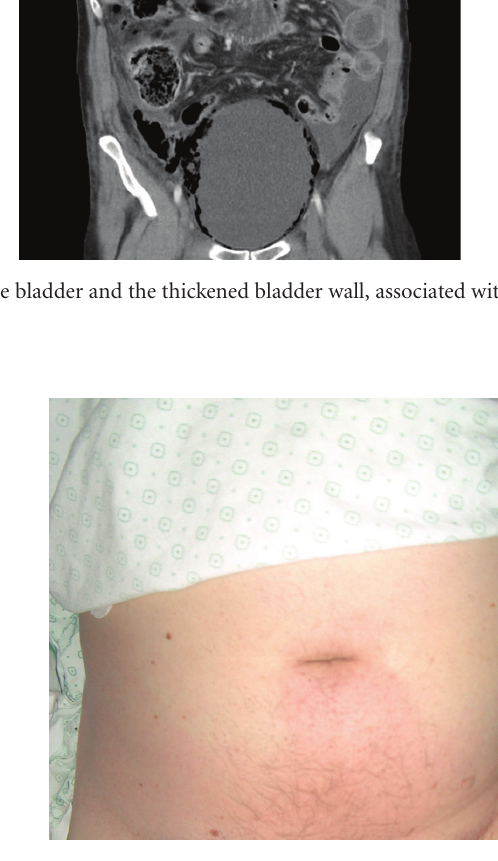
Figure 2: Patient developed a reddishness of the suprapubic region.